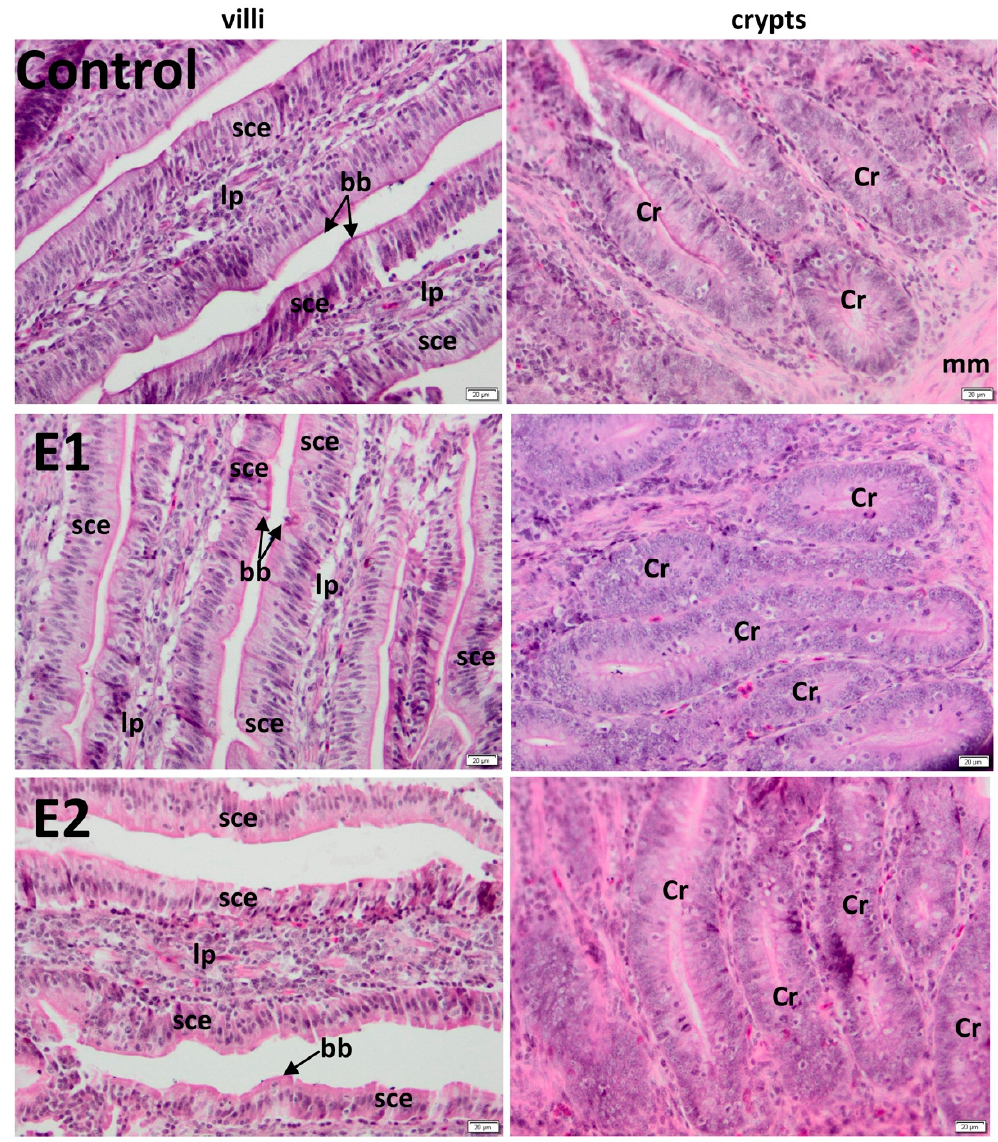
Figure 2. Effect of bilberry and walnut leaves supplementation diet on jejunum morphology of laying hens: The basal diet served as a control, and different levels of herbal feed additives were supplemented to the basal diet as follows: 0.5% cranberry leaves (E1) and 1% walnut leaves (E2). Sce: simple columnar epithelium; lp: lamina propria; Cr: crypt; mm: muscularis mucosa. bb: brush border; H&E (Hematoxylin and Eosin) stain; (n = 10); n: number of replicates. Table 3. Measurements of the villi length and widths of crypt for the control and experimental groups. Duodenum Jejunum Group Villus ( µ m) Crypt ( µ m) Villus ( µ m) Crypt ( µ m) C 891.55 ± 15 189.94 ± 11 905.98 ± 27